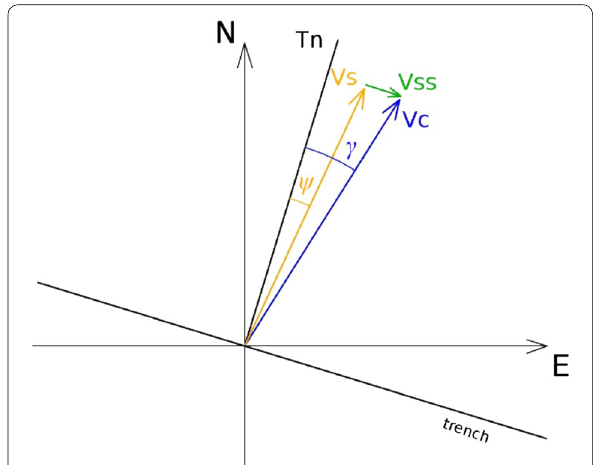
Fig. 5 Schematic representation of oblique subduction system kinematics. Black line ( T n )—normal to the trench, blue arrow ( V c )— convergence velocity vector, orange arrow ( V s )—coseismic slip vector,